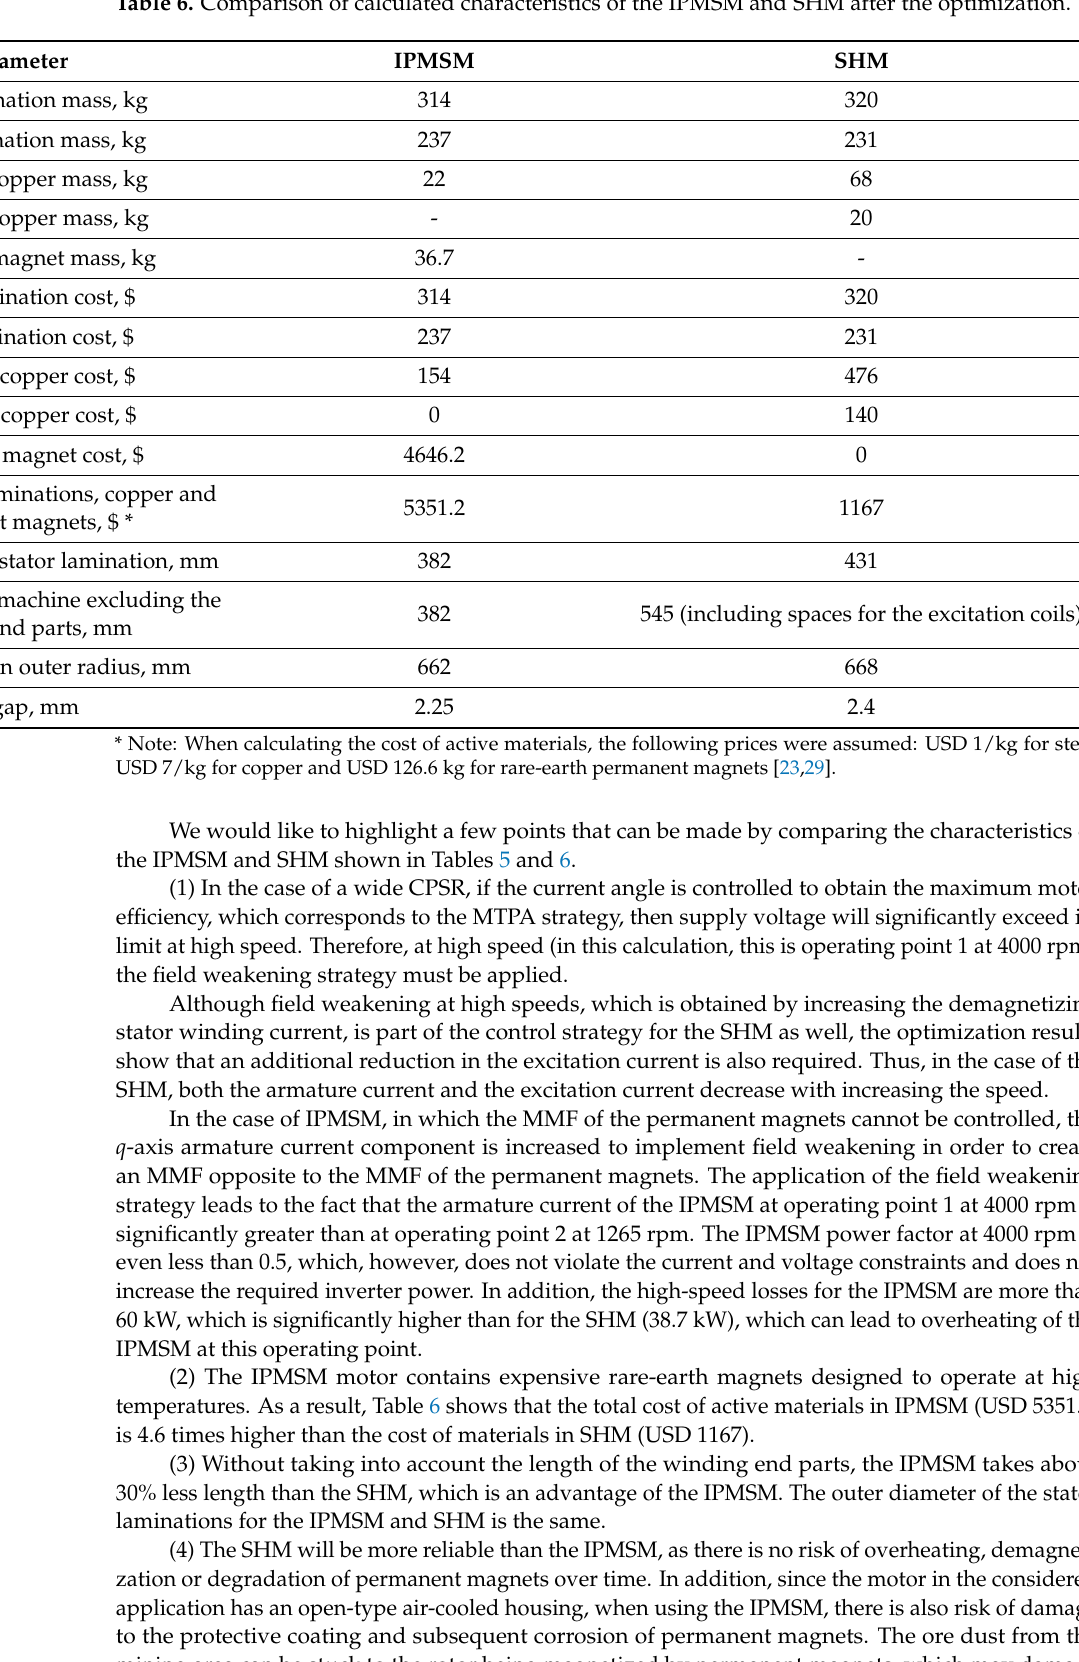
Table 6. Comparison of calculated characteristics of the IPMSM and SHM after the